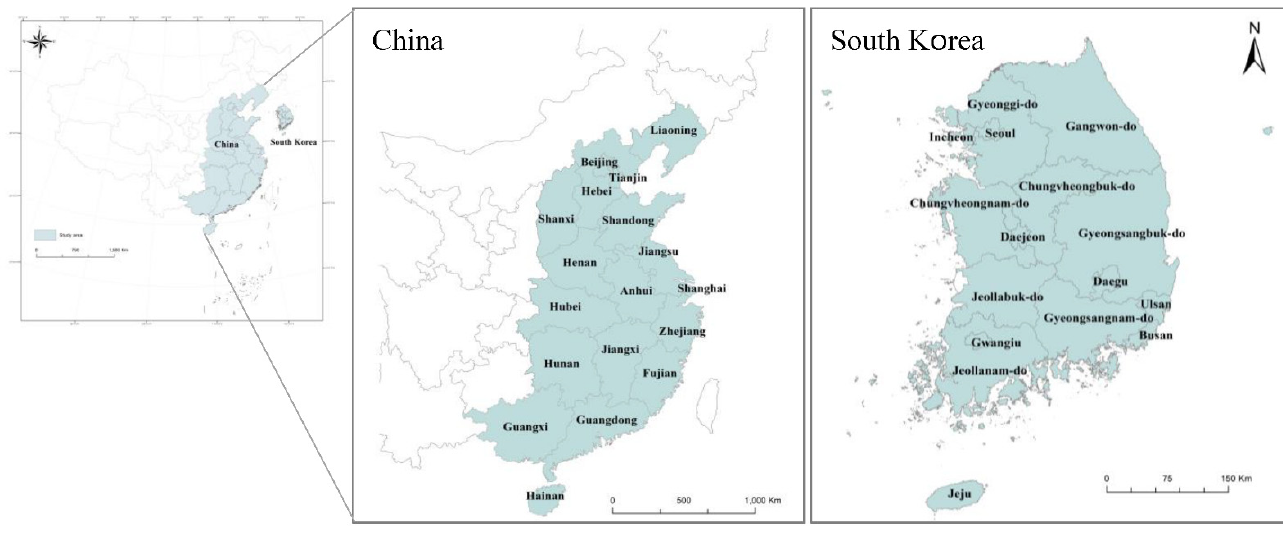
Figure 2. Study area. Table 1. Livability indicators used in this study .